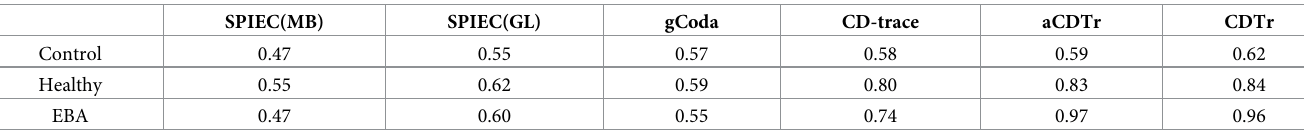
Table 7. The mean reproducibility for various methods and